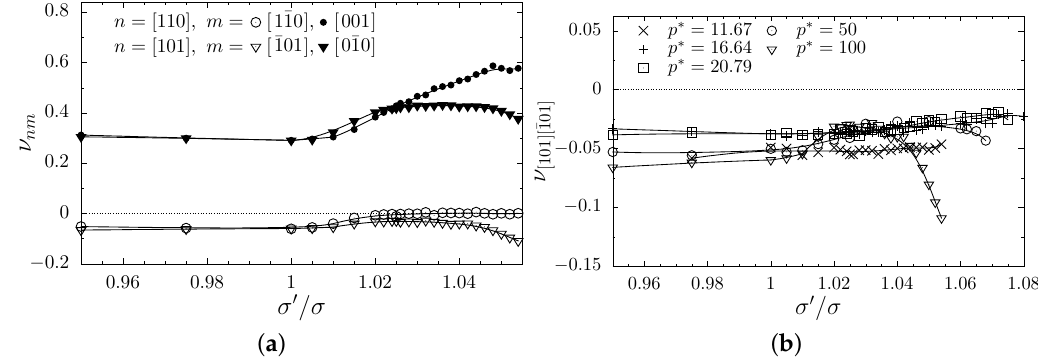
Figure 7. ( a ) The comparison of the Poisson’s ratio the [ 110 ] - and [ 101 ] -directions, which are equivalent in cubic systems ( σ (cid:48) / σ = 1), plotted as a function of σ (cid:48) / σ ratio. ( b ) The dependence of Poisson’s ratio in the [ 101 ][ ¯101 ] -direction on the external pressure conditions. The lines are drawn to guide the